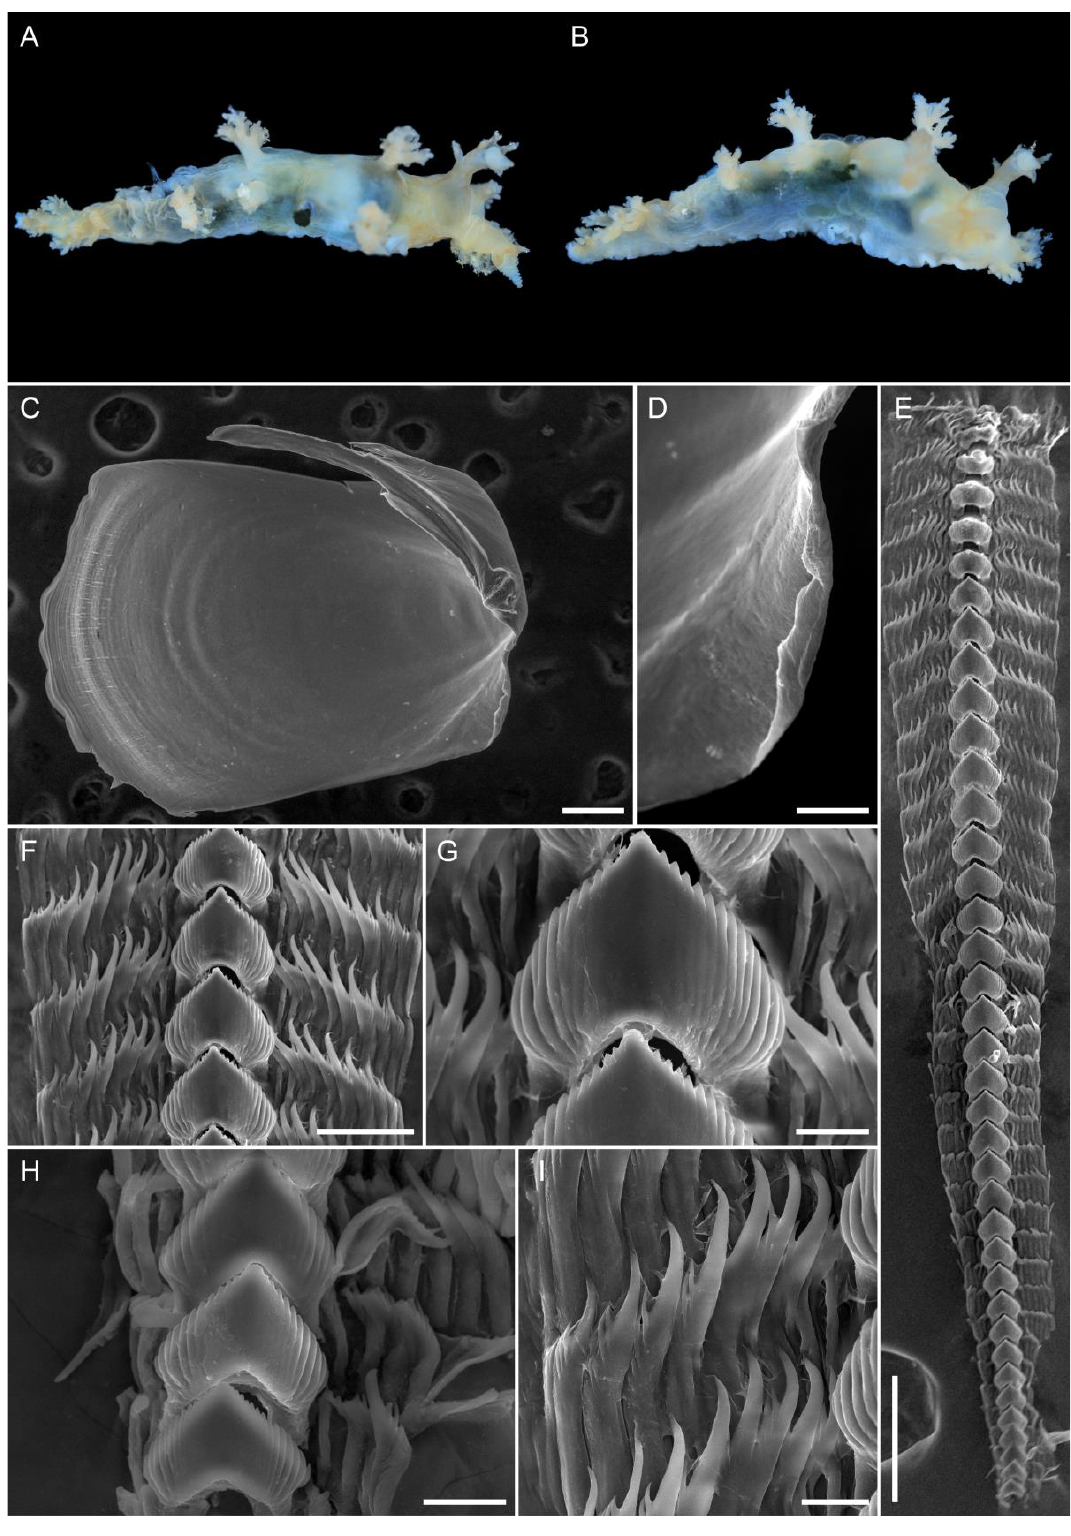
Figure 7. Dendronotus babai sp. nov., features of external and internal morphology (SEM) of holotype MIMB44623. ( A , B ) — living holotype, dorsal view ( A ) and lateral view from the right ( B ). ( C ) — left jaw plate. ( D — masticatory process of the jaw. ( E ) — radula. ( F ) — posterior radular portion. ( G ) — rachidian tooth. ( H ) — rachidian teeth, anterior radular portion. ( I ) — lateral teeth. Scale bars: ( C , E ) = 300 µm; ( D , F ) = 100 µm; ( G – I ) = 30 µm.